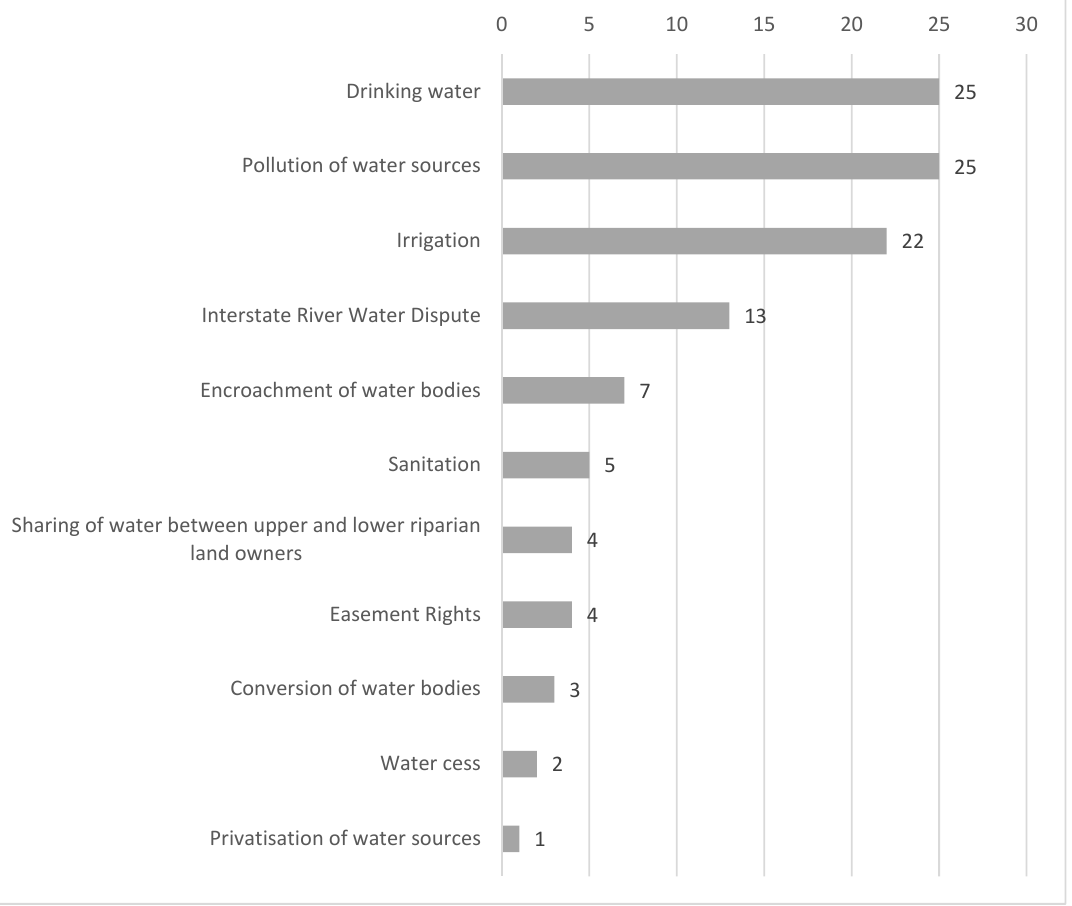
Figure 5. Overlapping distribution of claims decided by the Supreme Court post-1950 .